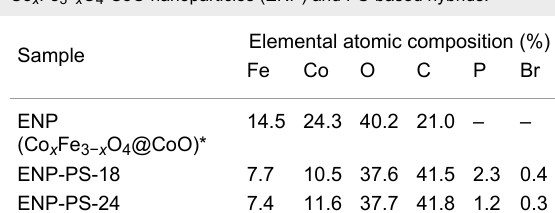
Table 1: XPS-determined atomic composition of as-prepared Co x Fe 3 − x O 4 -CoO nanoparticles (ENP) and PS-based